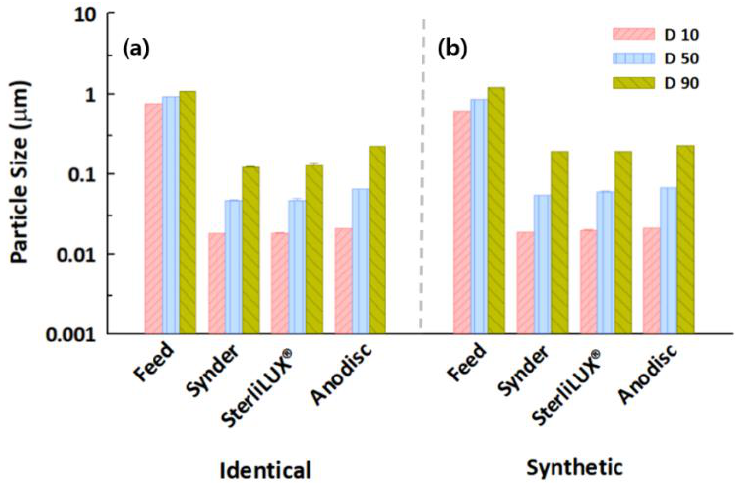
Figure 9. Particle size distribution in the feed and permeate water samples after membrane filtration with the diameter values of the (a) identical and (b) synthetic wastewater for the 1.0 μm PS microplastics.